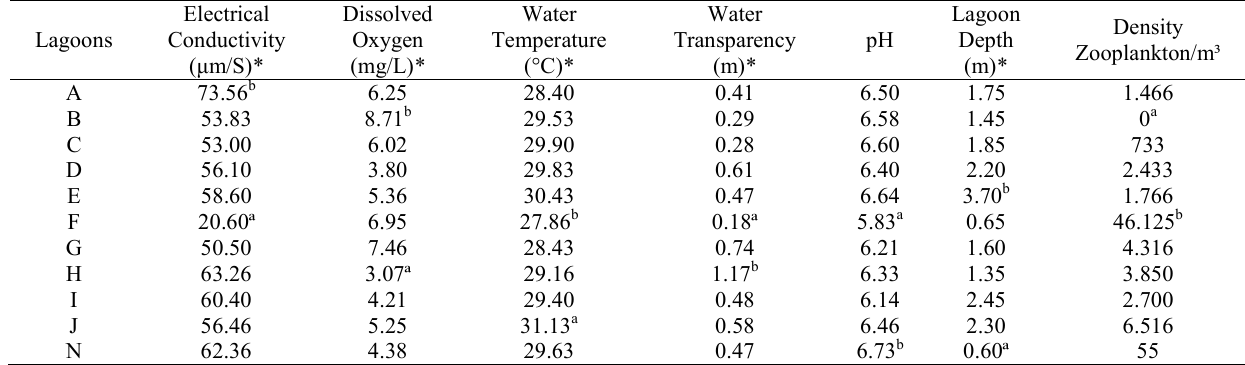
Table 2. Variation of the abiotic e biotic factors in marginal lagoons along the Cuiabá River in December 2006. Mean values by lagoon; a Minimum; b Maximum.